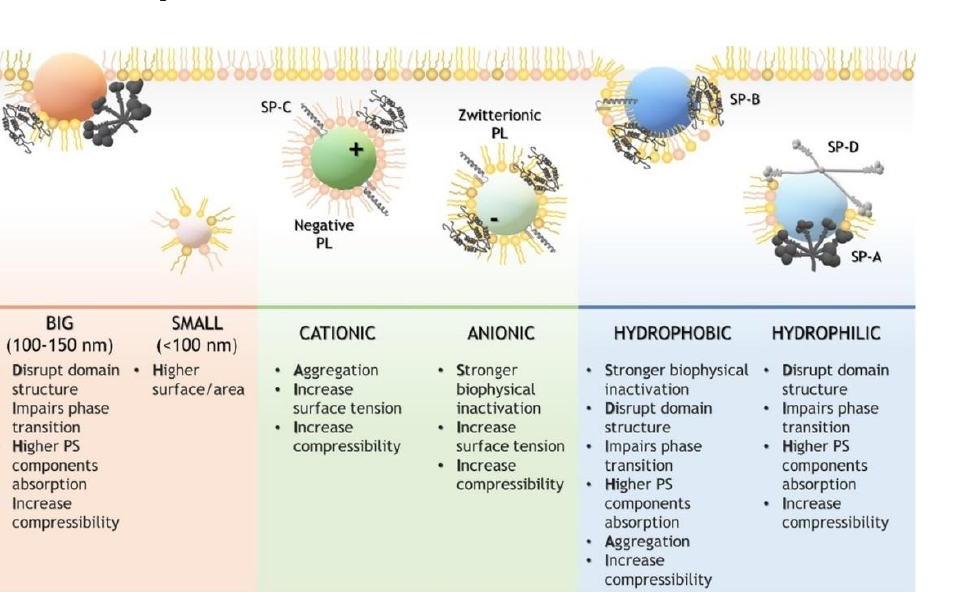
Figure 9. Impact of different physico-chemical properties of the particles in the LS performance. General perspective of the main effects and interactions of particles upon contact with LS. Reprinted from García-Mouton et al. [7], with permission from Elsevier, Copyright 2019.